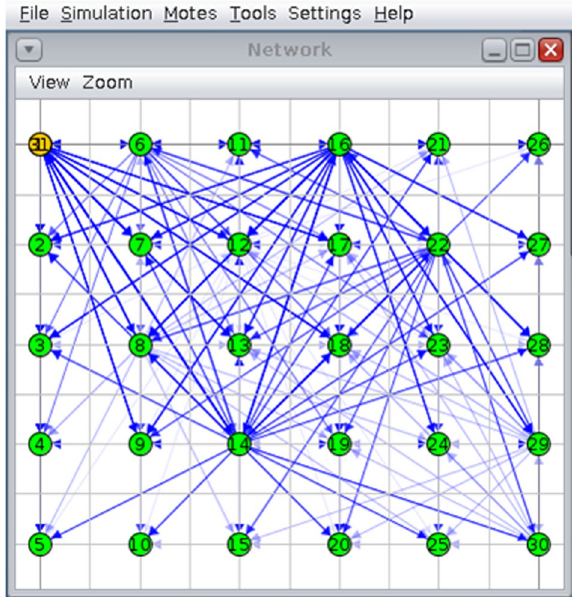
Fig. 9 Advanced smart home with linear